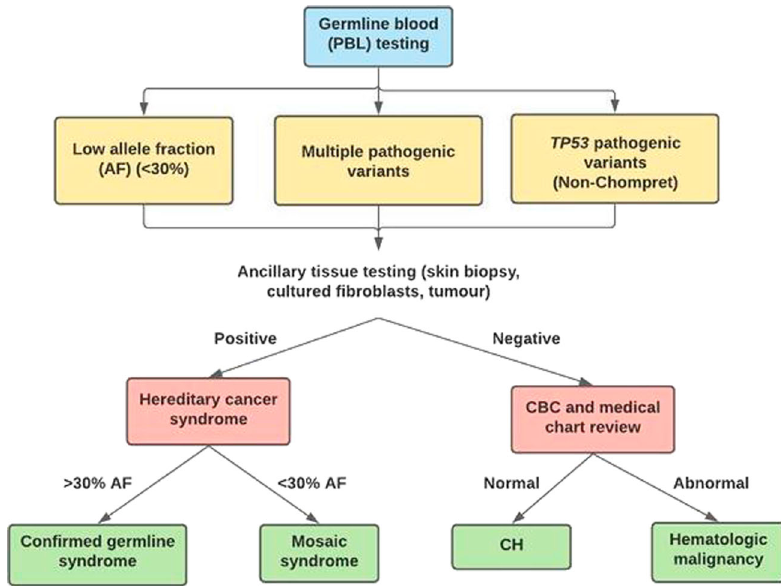
Fig. 1 Genetic fi ndings. Recommended diagnostic algorithm for patients presenting with potential incidental fi ndings identi fi ed through NGS-MGP testing on peripheral blood leukocyte (PBL)-derived DNA. Genetic fi ndings in individuals undergoing germline NGS-MGP testing on PBLs are classi fi ed in one of three categories and subsequently undergo further testing to identify downstream surveillance and diagnosis. This includes secondary tissue analysis (culture skin biopsy preferred) and medical chart review. CBC complete blood